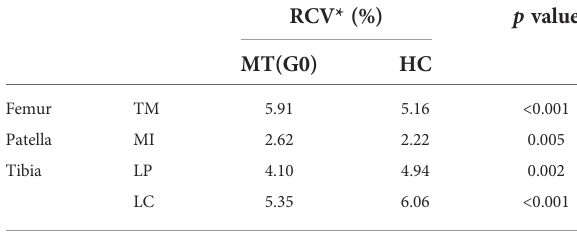
TABLE 6 Comparison of the relative cartilage volume percentage of the articular cartilage 21 subregion between the healthy control group and the meniscus tear group Grade 0 subgroup (only showing the subregions with signi fi cant